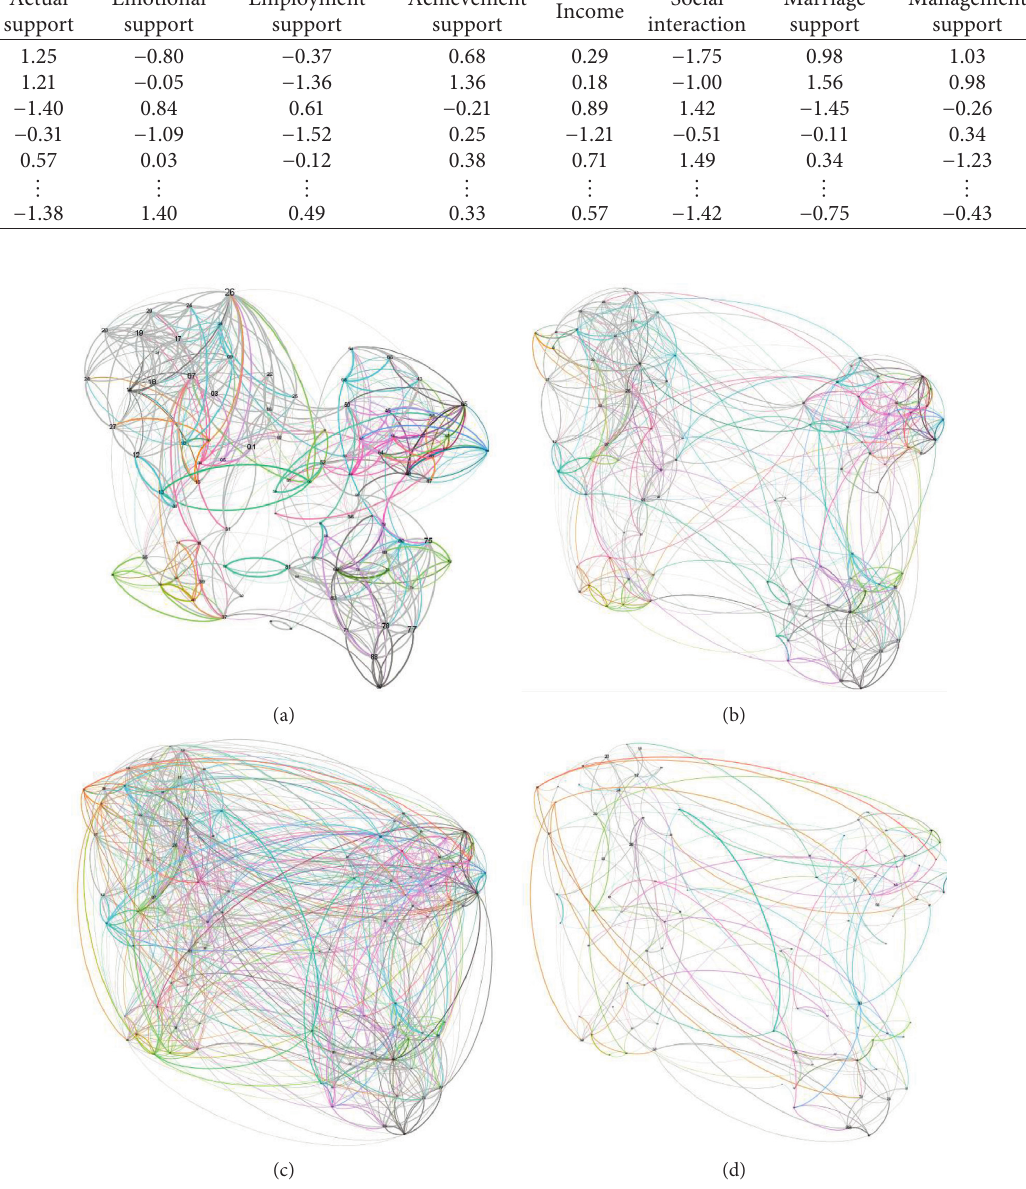
Figure 4: The evolution of the network structure of athletes. (a) The original. (b) After 100 iterations. (c) After 500 iterations. (d) After 1000